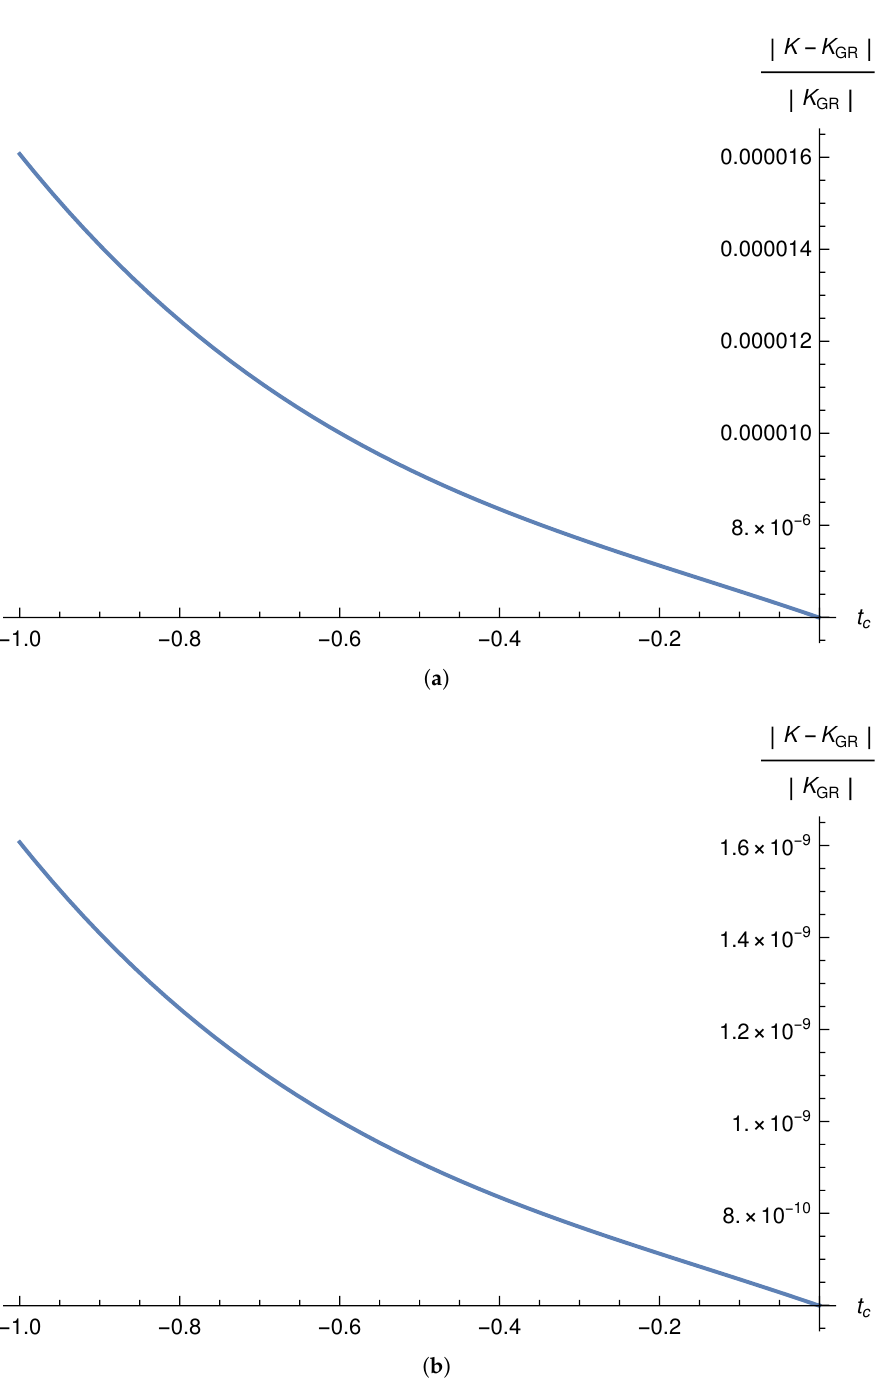
Figure 6. Plots of the relative difference between the Kretschmann scalars K and K GR in the α 1 (cid:54) = 0 case, for ( a ) m = 10 6 , and ( b ) m = 10 12